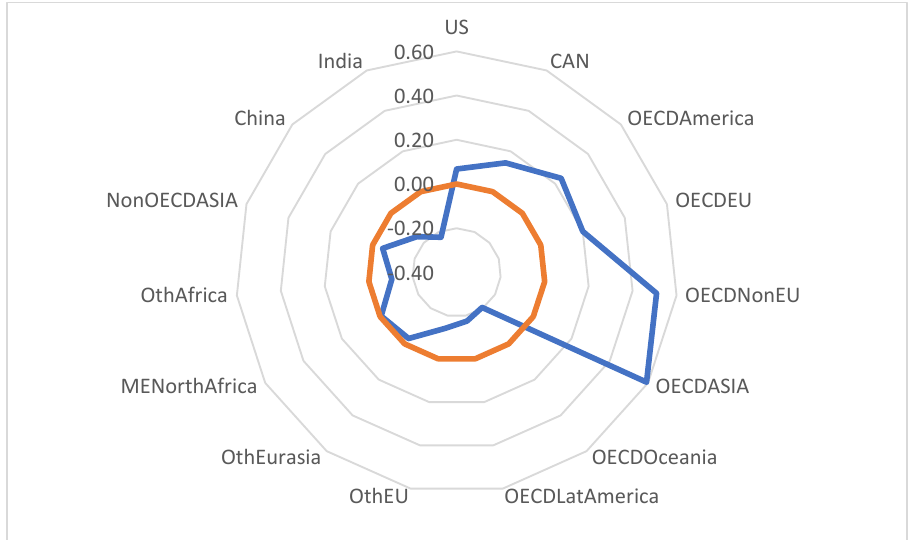
Figure 4. Correlation diagram of the effects of the implementation of the circular economy on end-of-life plastic waste (PWCR vs PWRELF).